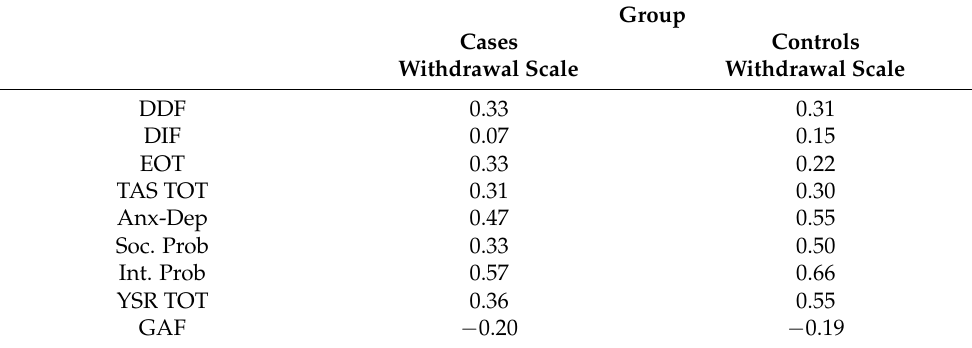
Table A1. Pearson’s r correlations between the social withdrawal scale of the YSR and the other scales of the YSR, the TAS-20, and the GAF, considering cases and controls